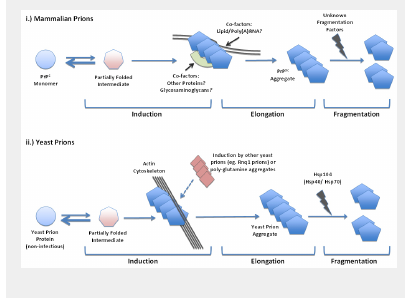
The induction, propagation and fragmentation of mammalian and yeast prions are compared. Partial unfolding of proteins with prion domains and/or the presence of other cellular factors may influence susceptibility to misfolding. (i) In the presence of a prion seed, PrP C is converted to PrP Sc thereby elongating the PrP Sc fibril. Conversion is likely to be aided by the presence of lipids and/or other co-factors and aggregates are fragmented by an as yet unidentified fragmentation process. (ii) Induction of yeast prions depends on interaction with actin cytoskeleton and/or cross-seeding by other yeast prions or yeast proteins with Gln/Asn-rich domains. Fragmentation of yeast prion aggregates is accomplished by the yeast protein chaperones Hsp104 and Hsp70/